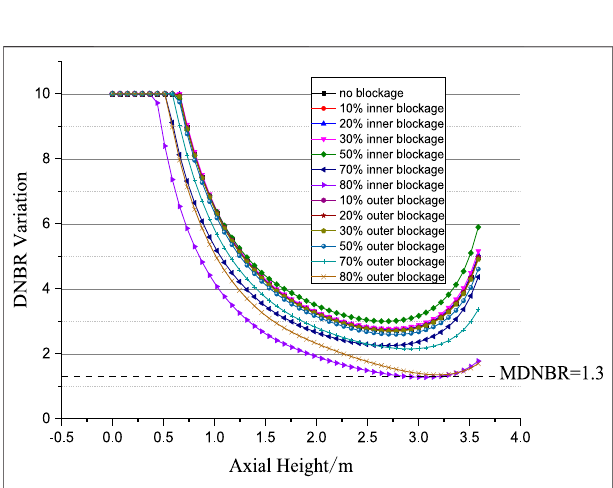
FIGURE 18 | MDNBR variation along with axial height under different blockage.